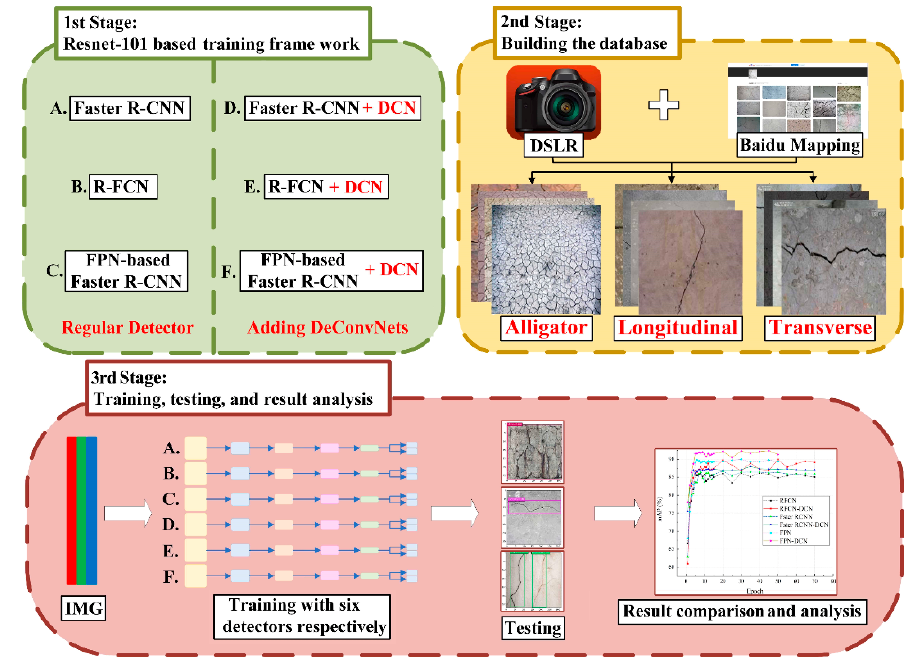
Figure 1. Overall schematic diagram of the proposed method.